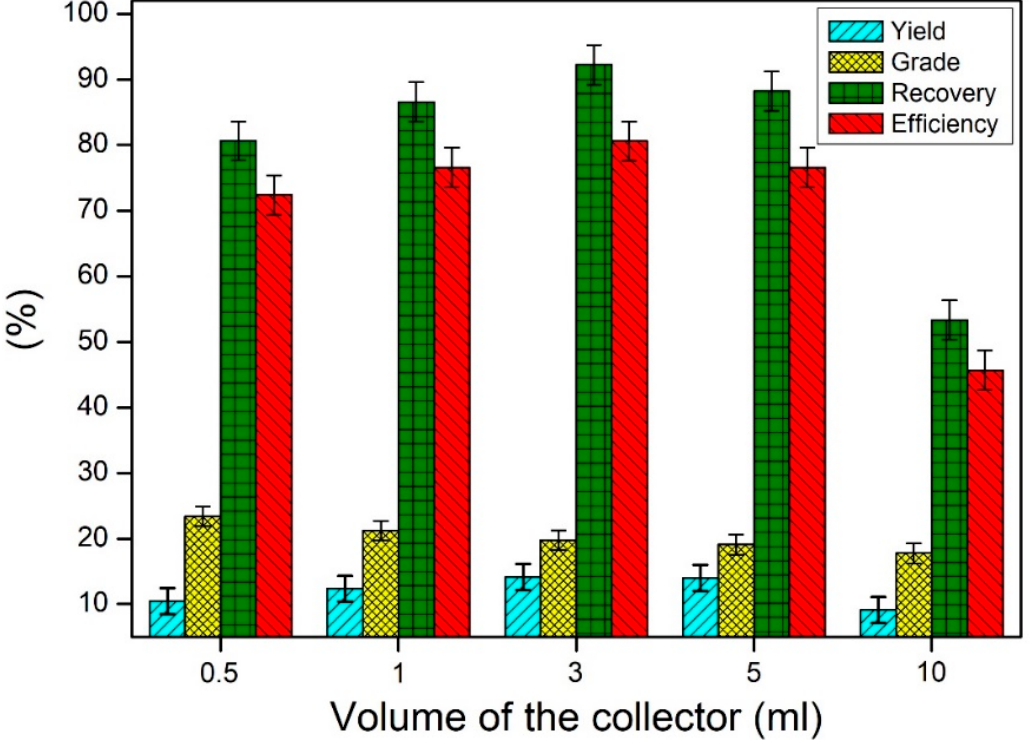
Figure 7. The effect of the collector volume on the yield of carbon concentrate, the grade of carbon, recovery (R), and flotation efficiency (E) for the non ‐ magnetic fraction of the CFA (diesel is the collector, with a particle size 71–100 μ m and a flotation duration of 240 s).